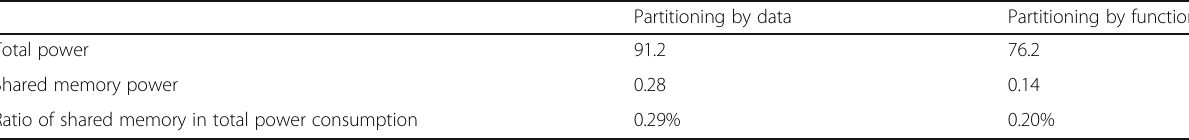
Table 2 Power consumption of shared storage area